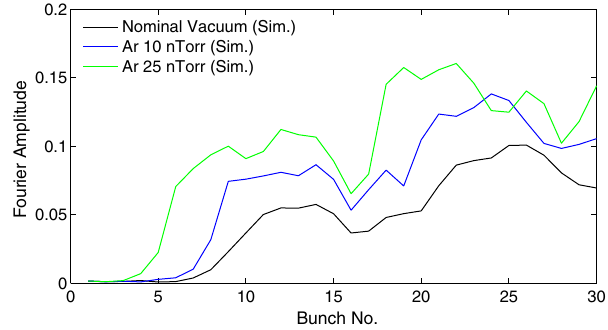
FIG. 7. Amplitude at vertical tune, obtained from FFT of vertical bunch motion (in mm), as a function of bunch number at different pressures, as predicted by simulation.